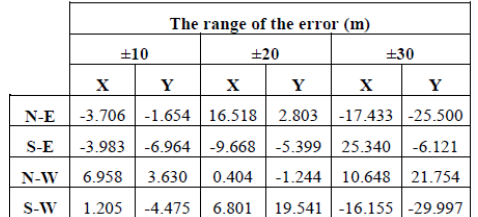
Table 2. The perturbation error added to each region for the three simulated